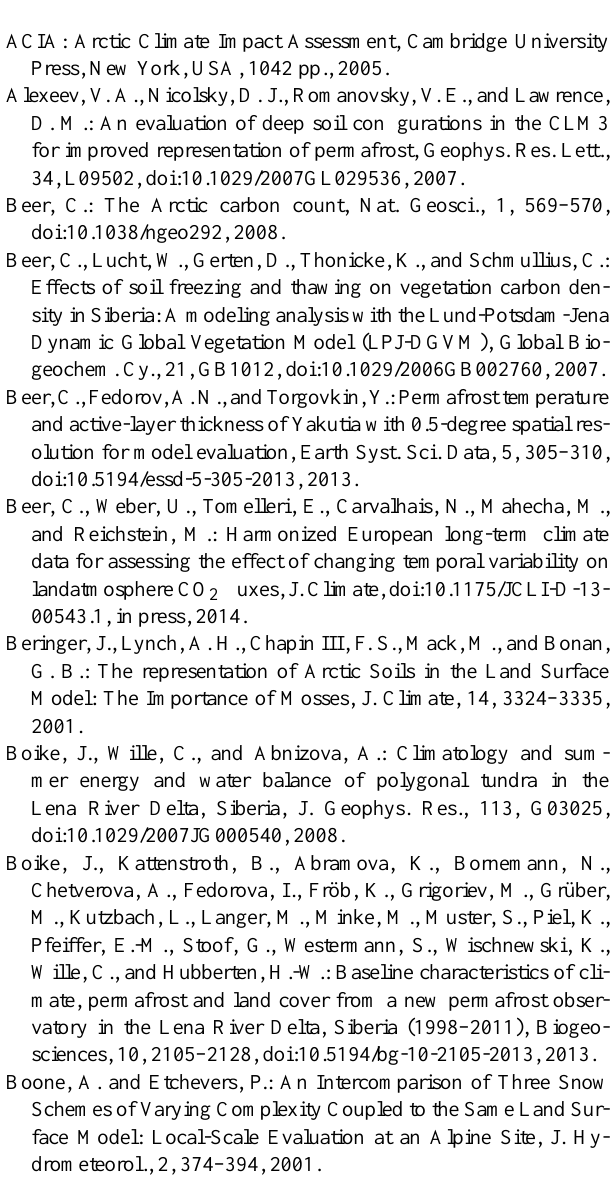
Fig. 17. Simulated and observed annual Yenisey River runoff. Red line represents the JSBACH model version with the permafrost rep- resentation. The black line shows the observed values from the R- ArcticNet database (Lammers et al., 2001).